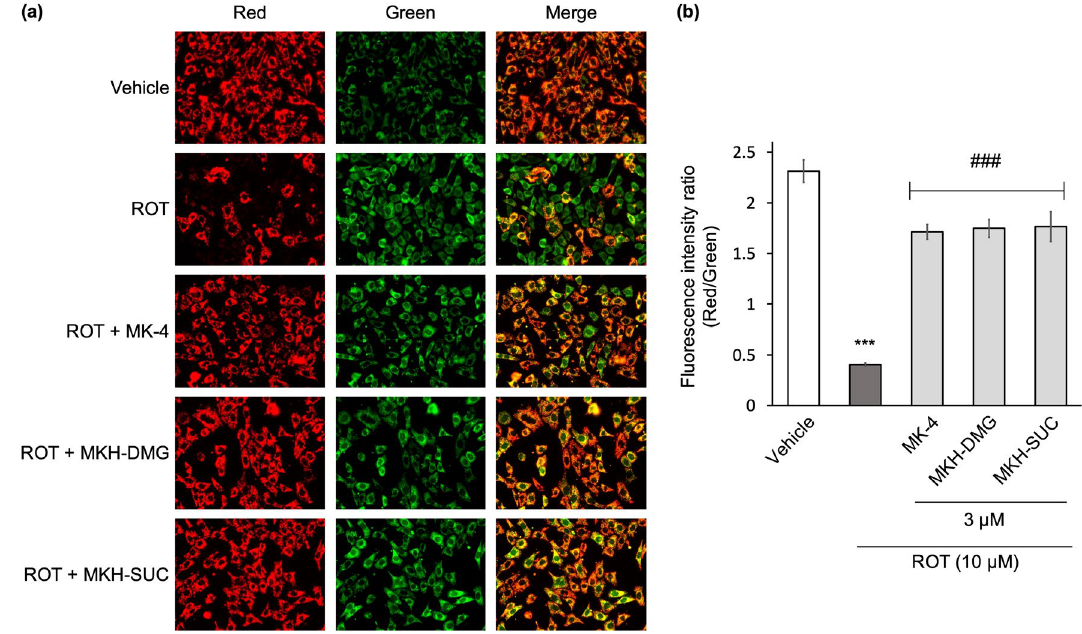
Figure 4. Influence of MK-4 and MKH derivatives on ROT-induced reduction of MMP. The NIH/3T3 cells were treated with 3 µM MK-4, MKH-DMG, or MKH-SUC for 6 h in the presence of 10 µM ROT. MMP was evaluated by JC-1 staining ( a ) Fluorescence microscopic image, ( b ) Fluorescence intensity ratio (Red/Green) quantified using a microplate reader. ***p < 0.001 versus vehicle group; ### p < 0.001 ROT only group (Tukey’s test). Mean ± SD (n =